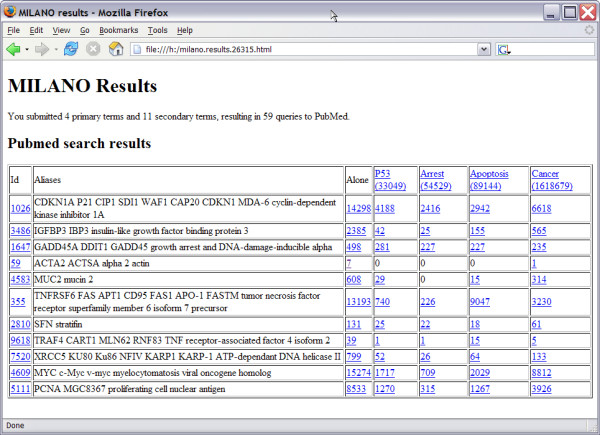
An example of a result of MILANO search using a short list of gene symbols that were expanded by the program to include all their informative synonyms versus p53 related terms. All reported numbers are hyperlinked and will initiate a new search for that specific term combination.